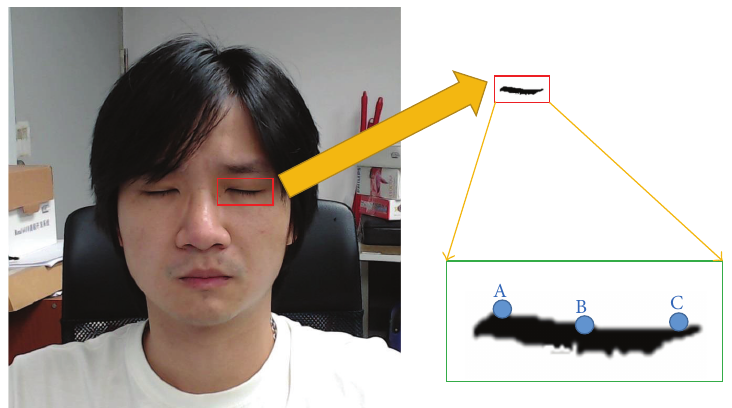
Figure 10: Illustration of blinking eyelid detection for fatigue monitoring.